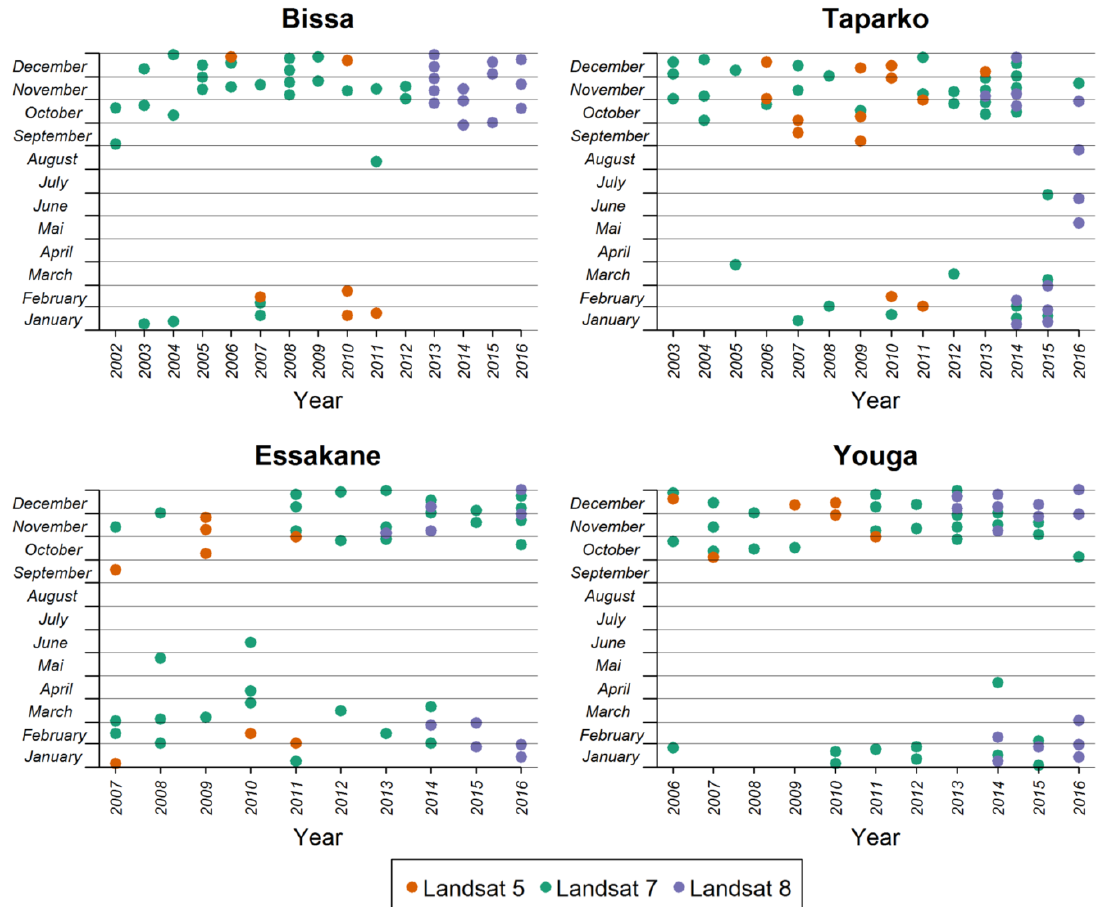
Figure 3. Capture dates of images retained after the visual quality assessment for each study site and year.